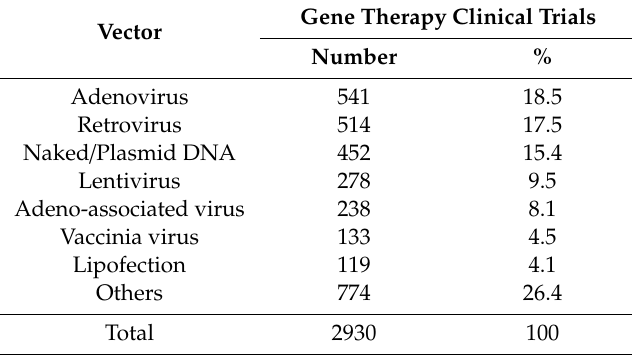
Table 1. Types and relative numbers of the top seven clinically approved vectors used in gene